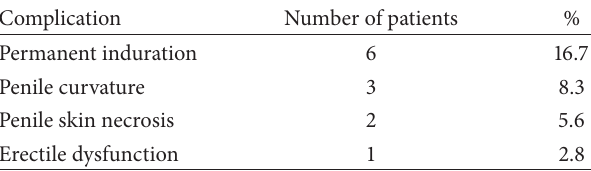
Figure1:Theclassicalpresentationofpenisfracture.Thehematoma and the bending of penis seen in penile fracture.